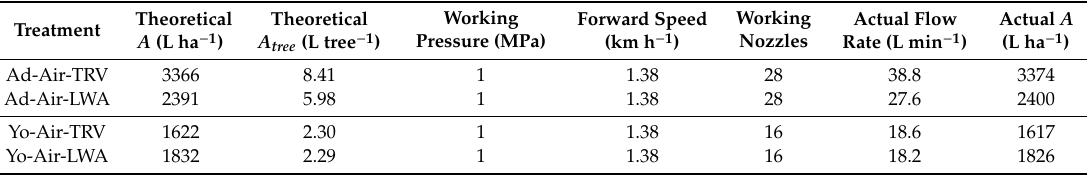
Table 4. Working conditions for tests with the air-blast